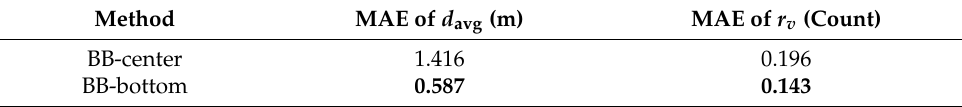
Table 4. Social distancing detection